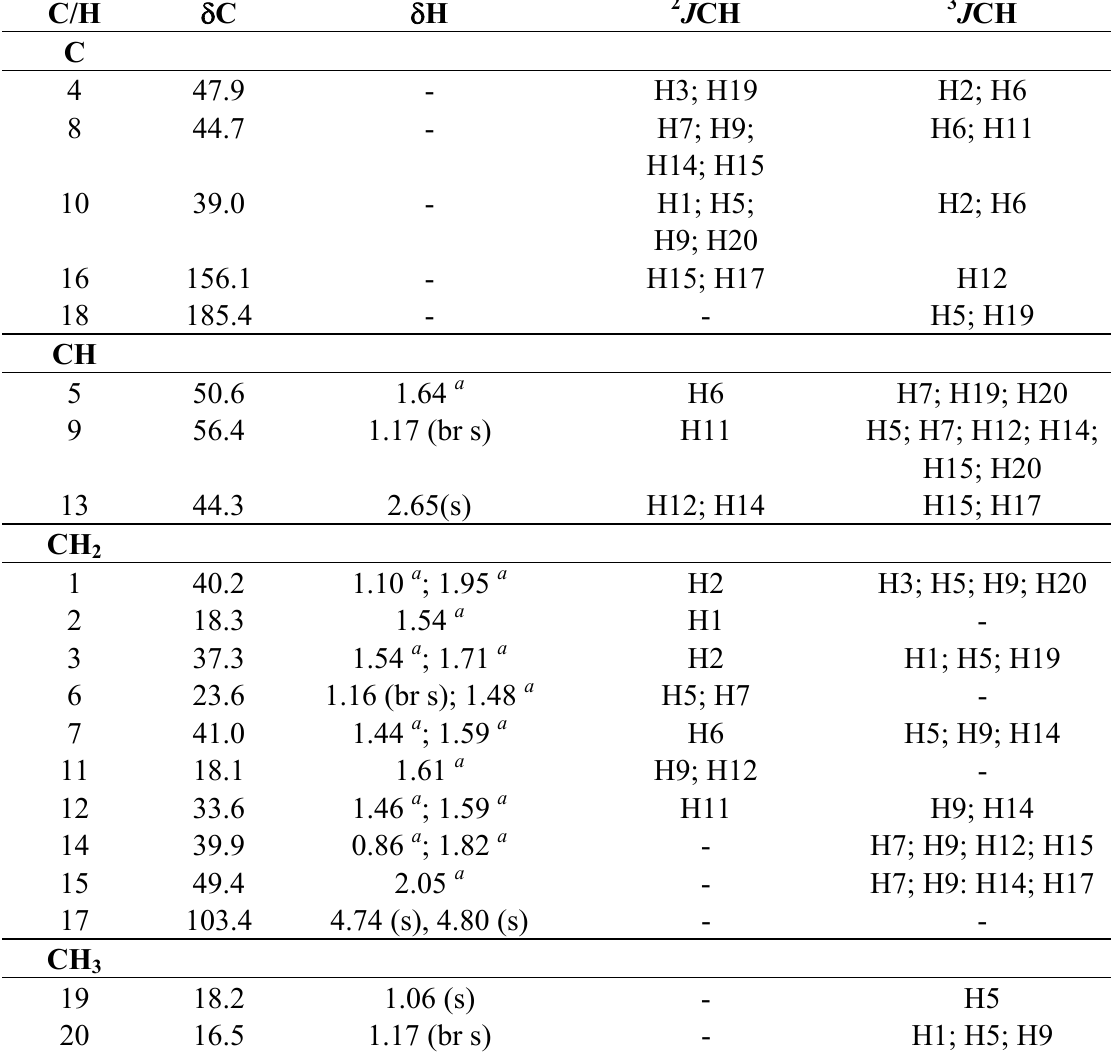
Table 1. HMQC and HMBC spectra data of compound 1 (CDCl